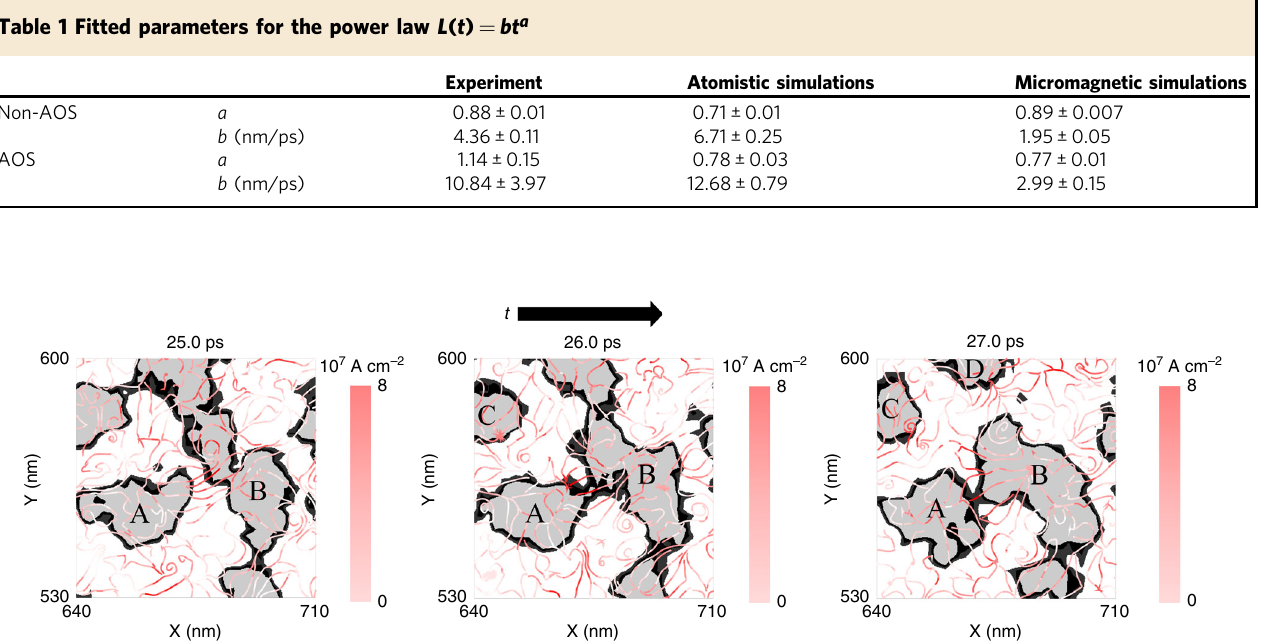
Table 1 Fitted parameters for the power law L ( t ) = bt a